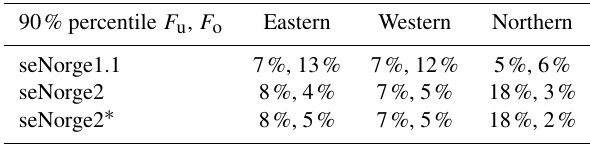
Table 1. 90% percentile values of the model underestimation ( F u ) and overestimation ( F o ) (in % of grid cells) in the three regions and for the two versions of the conventional climate